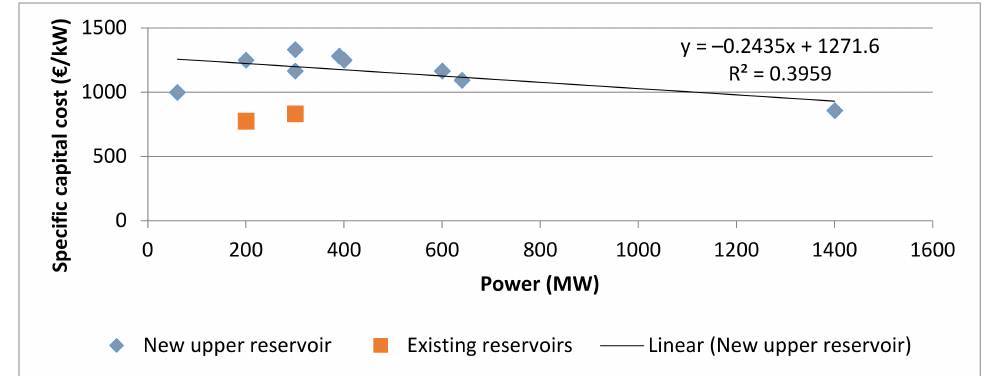
Figure 3. Specific capital costs of PHS projects in Germany. Source: own illustration after [31].